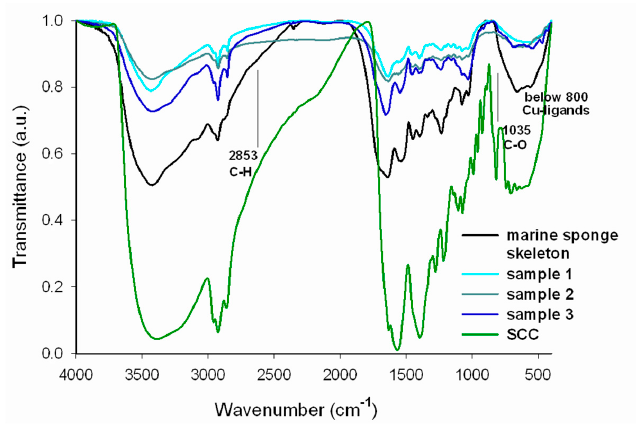
Figure 5. FTIR spectra of SCC, H. communis sponge skeletons and selected samples (sample 1: 50 mg/L, sample 2: 100 mg/L, sample 3: 200 mg/L; 60 min; pH neutral; 0.1 M NaCl). On the FTIR spectrum for the spongin (black line), the wide band at 3500–3200 cm − 1 is characteristic for deforming stretching vibrations of the hydroxyl group. Vibrations related to the presence of that group are also responsible for the signals at wavenumbers 1390 and 660 cm − 1 . The signal at 2930 cm − 1 is attributed to stretching vibrations of C–H bonds, and that at 1390 cm − 1 to deformation vibrations of the methyl group –CH 3 . The band at 1640 cm − 1 indicates the presence of stretching vibrations of the carbonyl chromophore C=O. The presence of aromatic rings in the structure of the spongin is confirmed by the two bands at 1540 and 1450 cm − 1 , both of which are attributed to vibrations of coupled C=C bonds in the aromatic ring. The signal at 1230 cm − 1 corresponds to stretching vibrations of C–O bonds in carboxyl groups. The remaining two bands at 1070 and 1020 cm − 1 are characteristic for stretching vibrations of C–O bonds in alcohols.